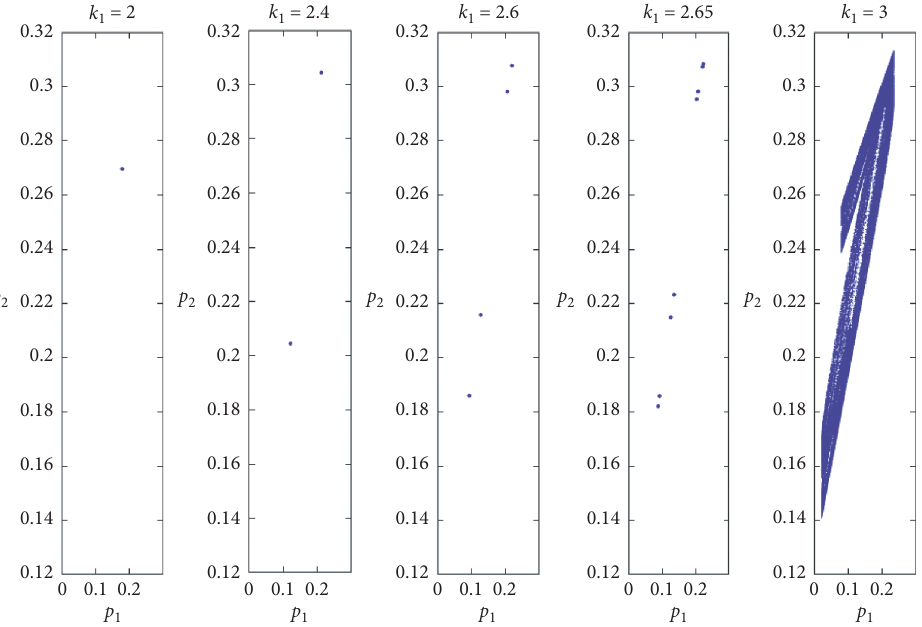
Figure 3: Phase portraits for Figure 2 with various values of k